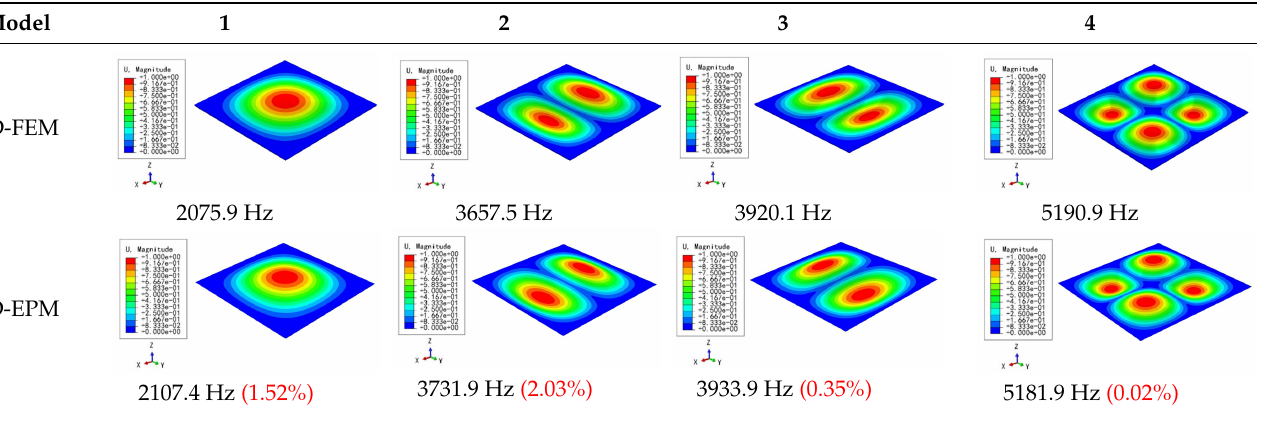
Table 16. Comparison of the first four free vibrations of the resized triangular HSP under CCCC boundary conditions predicted by different